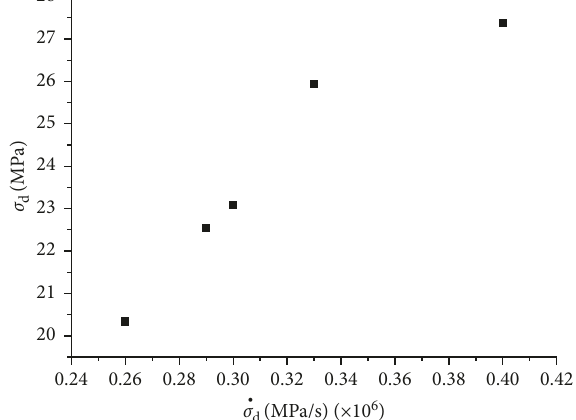
Figure 11: Relationship between dynamic tension strength and loading rate at depth 540m.